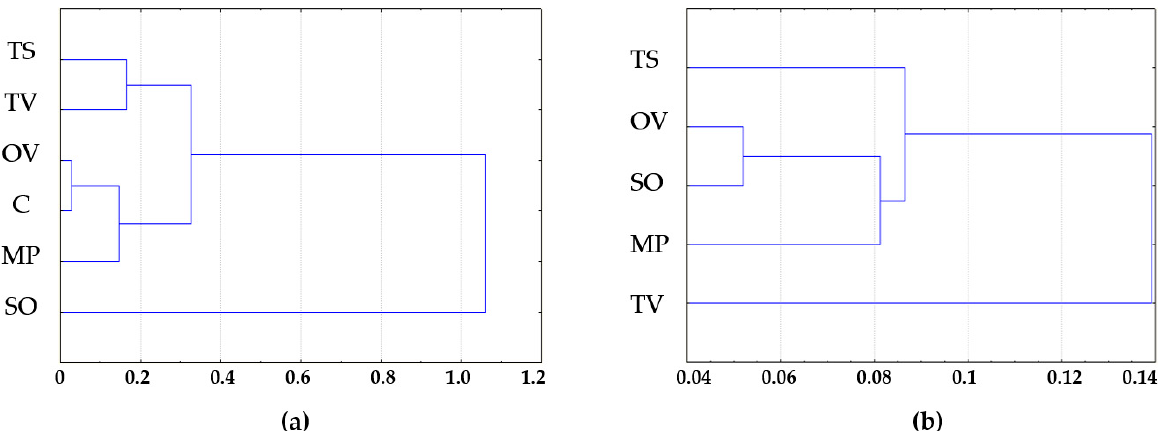
Figure 5. ( a ) Bacterial α -diversity—Shannon and Chao1 indexes; ( b ) Bacterial β -diversity—Bray–Curtis metrics clusters by Euclidean distance. MP is peppermint ( M. piperita L.), OV—oregano ( O. vulgare L.), TV—thyme ( T. vulgaris L.), TS—creeping thyme ( T. serpillum L.), SO—sage ( S. officinalis L.), C—control.